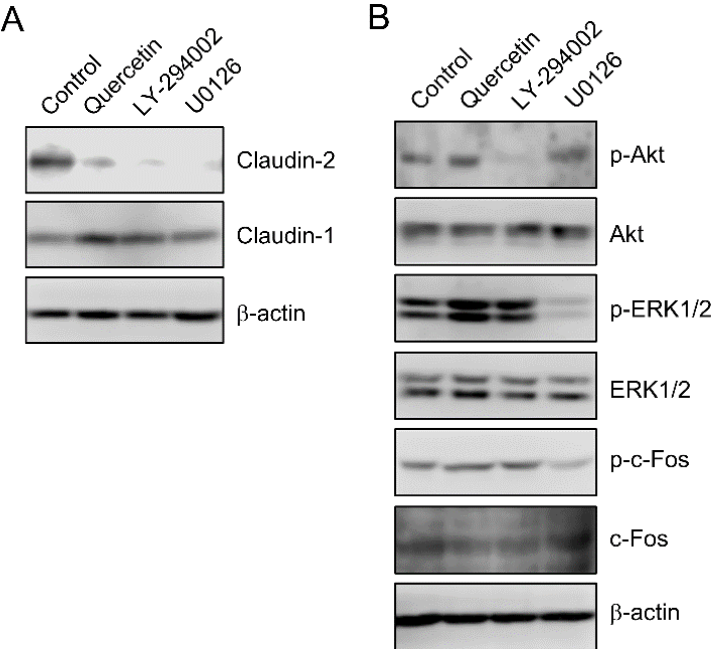
Figure 2. Effect of quercetin on the phosphorylation of ERK1/2 and Akt. ( A ) A549 cells were incubated in the absence (control) and presence of 50 μM quercetin, 10 μM LY-294002, or 10 μM U0126 for 24 h. Cytoplasmic fractions were immunoblotted with anti-claudin-1, claudin-2, or β-actin antibody; ( B ) Cells were incubated in the absence (control) and presence of 50 μM quercetin, 10 μM LY-294002, or 10 μM U0126 for 30 min. Cytoplasmic fractions were immunoblotted with anti-p-Akt, Akt, p-ERK1/2, ERK1/2, p-c-Fos, c-Fos, or β-actin